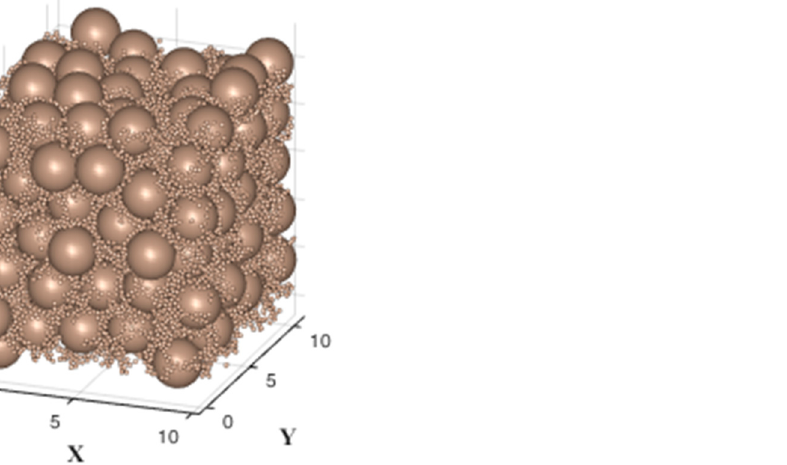
Figure 12. Packing result for the bi-dispersed propellant with wall boundary conditions applied in the x direction.